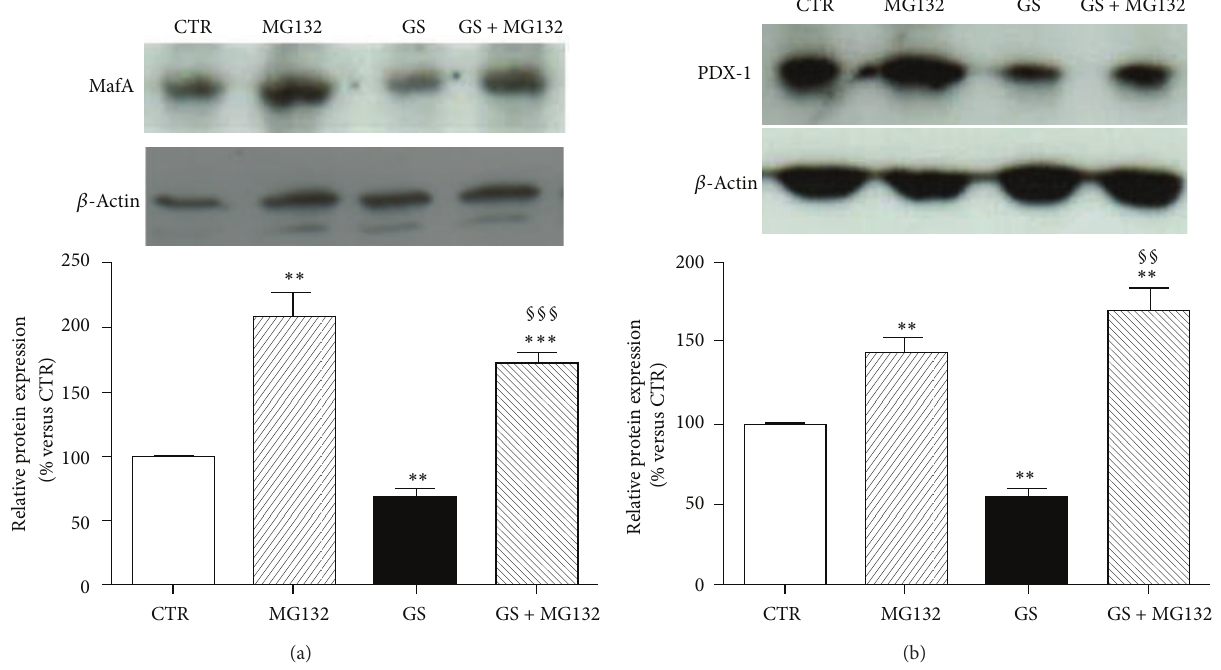
Figure 6: Pharmacological inhibition of proteasome increased accumulation of MafA and PDX-1. HIT-T15 cells were cultured for the last 15h in the presence or absence of the proteasome inhibitor MG-132, and whole cell extracts were analyzed by western blotting using specific antibodies against PDX-1 and MafA. Actin amounts were analyzed as a loading control. ∗ 𝑃 < 0.05 , ∗∗ 𝑃 < 0.01 and ∗∗∗ 𝑃 < 0.001 versus CTR or versus the same condition without